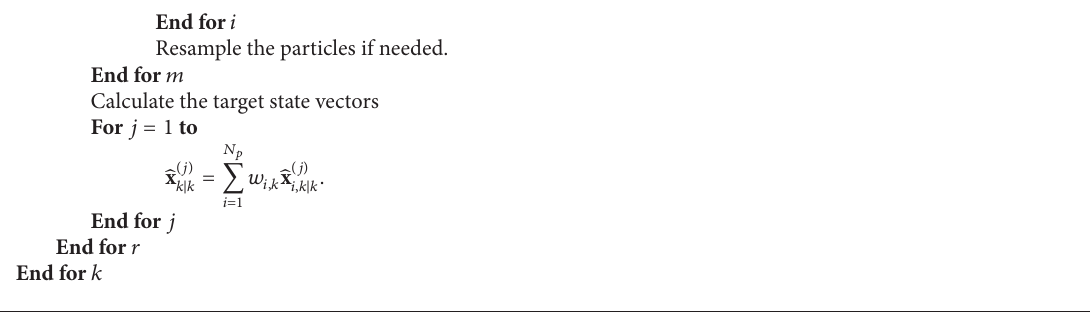
Algorithm 1: RBMCDA using gating